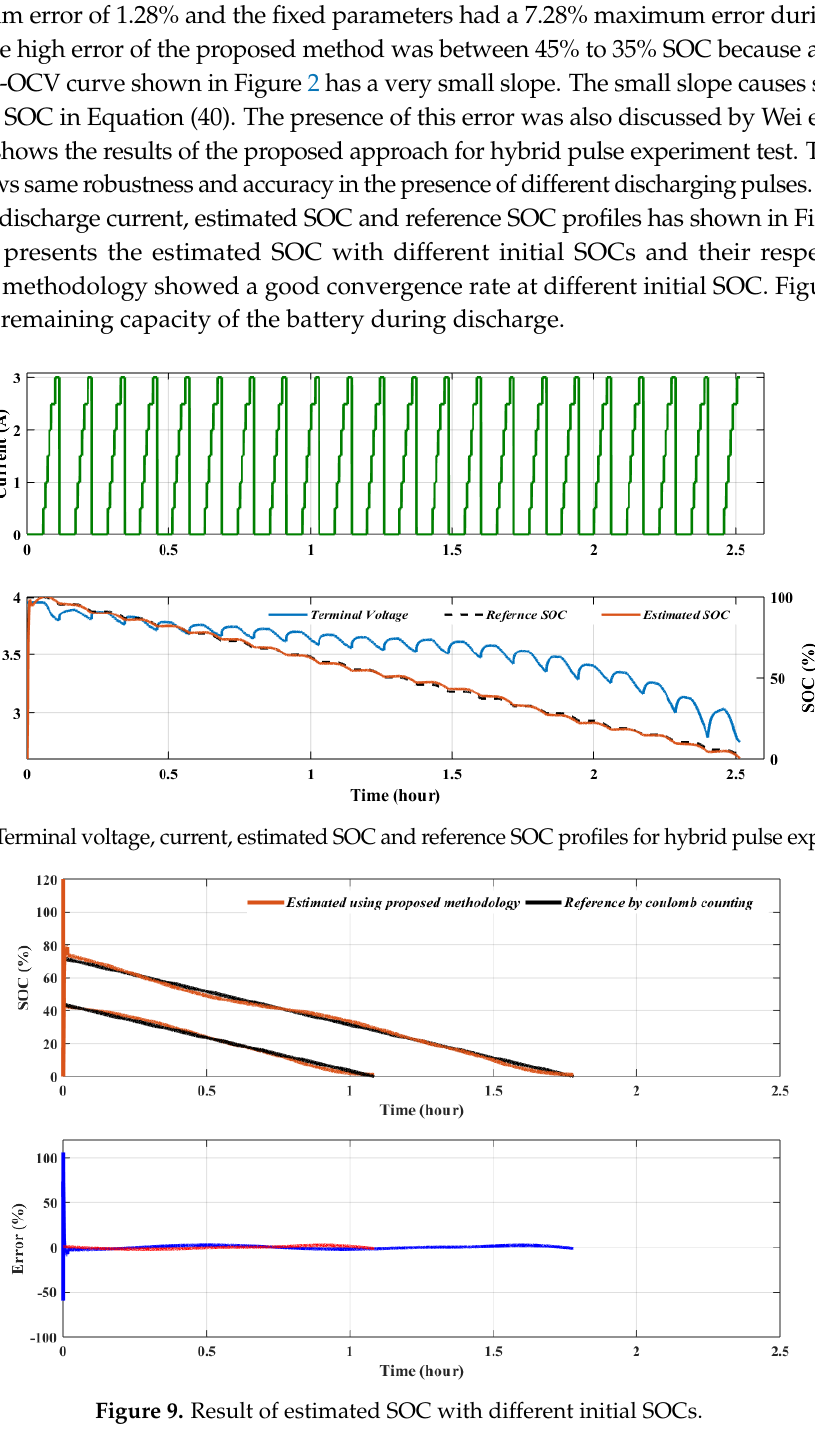
Figure 9. Result of estimated SOC with different initial SOCs.